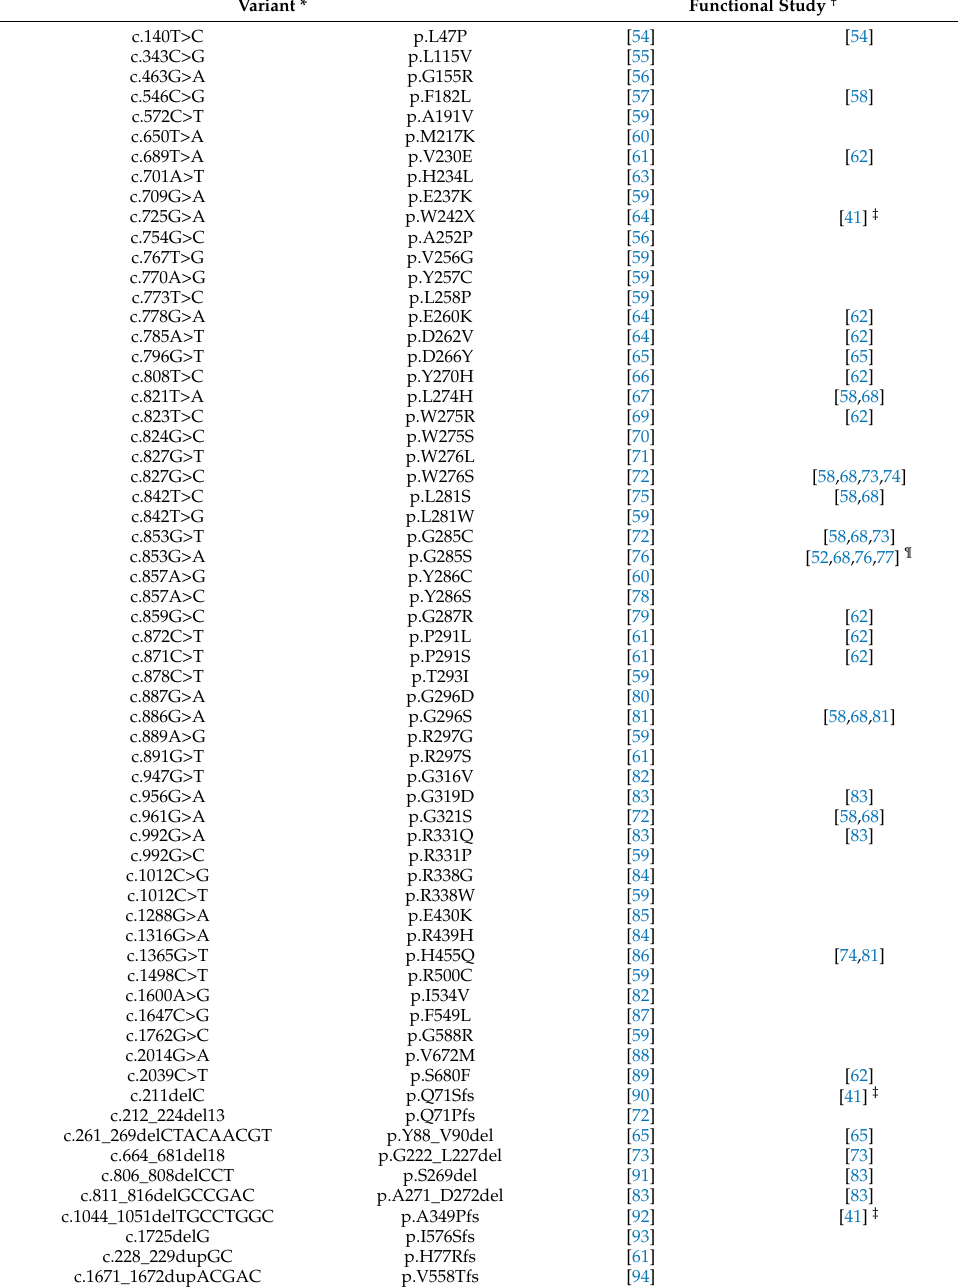
Table 2. DFNA2A-associated KCNQ4 variants that affect the amino acid sequence of the Kv7.4